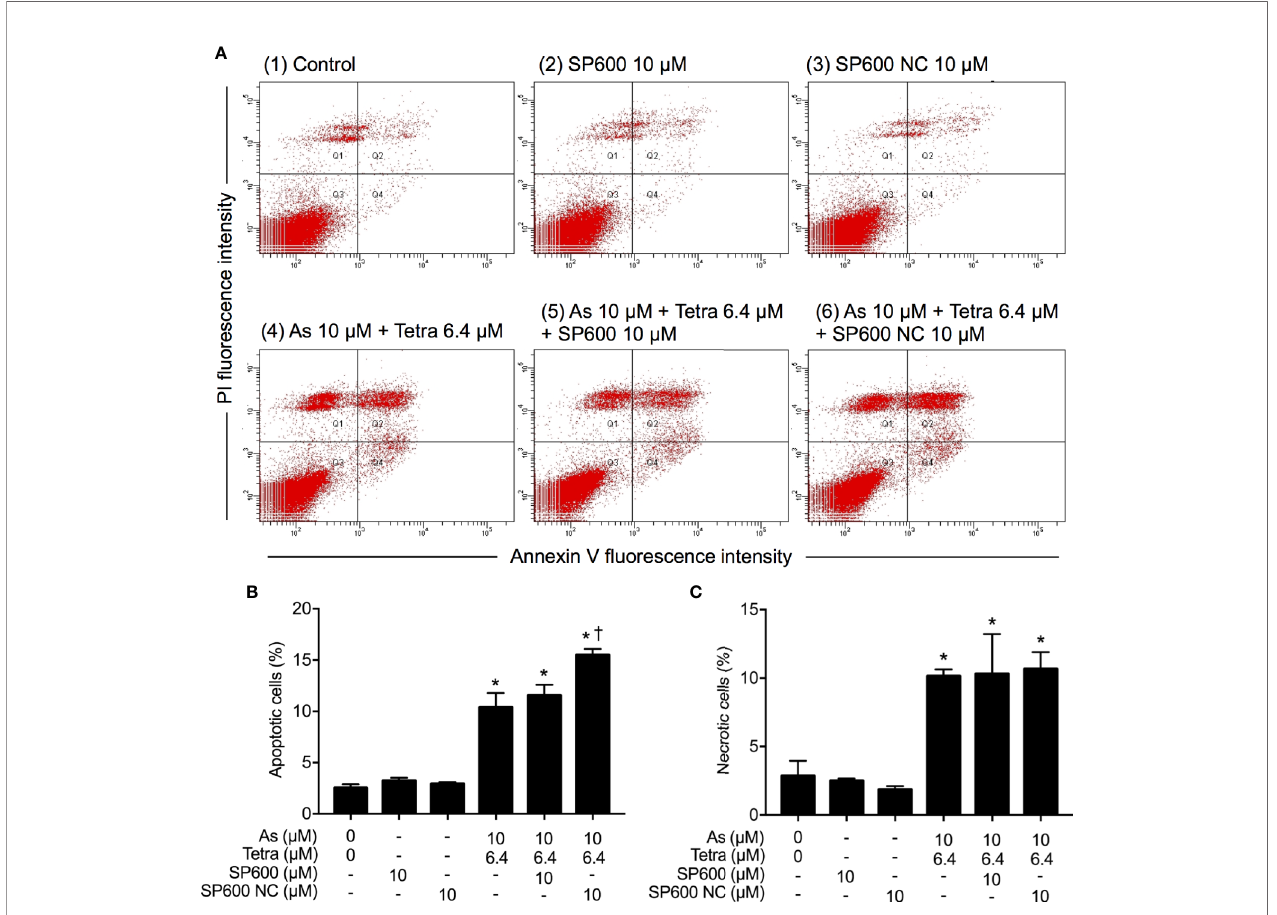
FIGURE 8 | Effect of SP600125 on the induction of apoptosis and necrosis in MDA-MB-231 cells treated with As III combined with Tetra. After treatment with 10 m M As III +6.4 m M Tetra in the presence or absence of 10 m M of SP600125 and its negative control SP600125NC for 48 h, cells were stained with annexin V-FITC and PI, and analyzed by fl ow cytometry. (A) Representative dot plots from three independent experiments are shown. The percentages of apoptotic cells (B) and necrotic cells (C) were quanti fi ed by the same manner as described in the legend of Figures 2 and 3. *p<0.0001 vs. control, † p<0.0001, vs. 10 m M As III +6.4 m M Tetra. As,